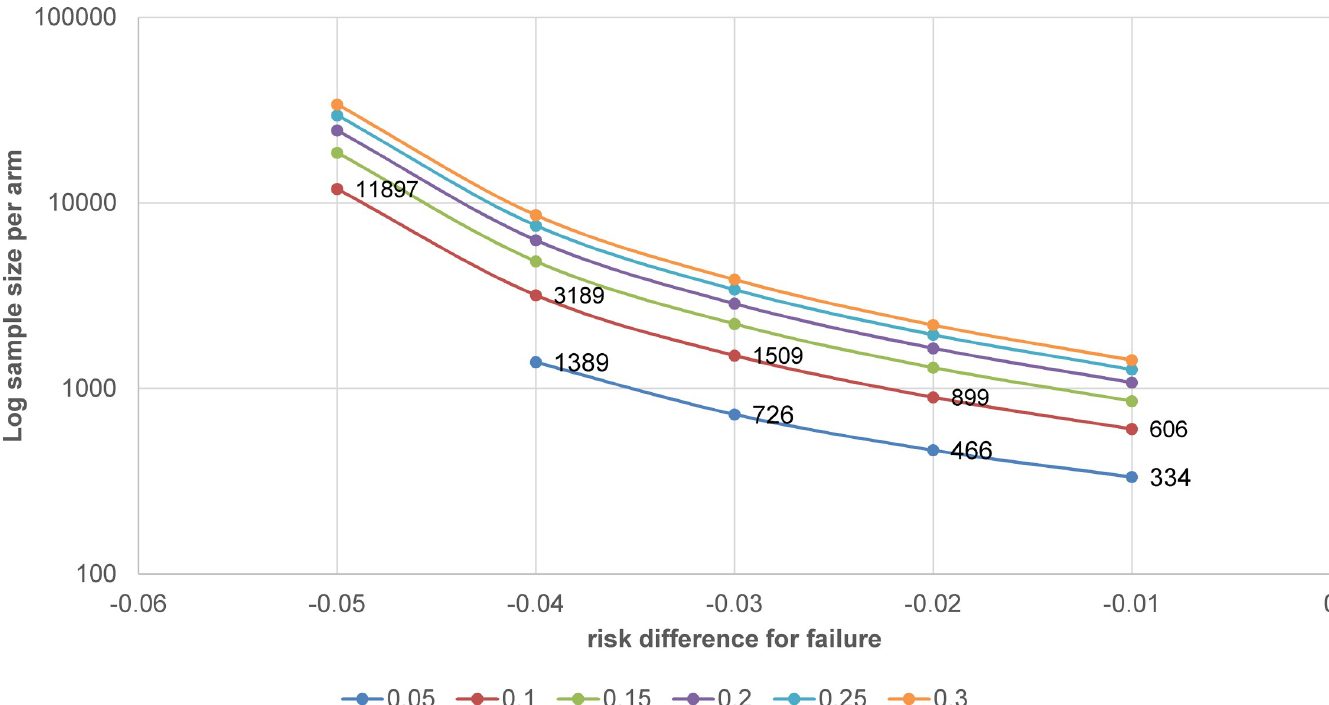
Fig 4. Example of sample size calculation with 1:1 allocation for noninferiority trial with noninferiority margin = 6%, failure rates in the control arm ranging from 5% to 30% (solid lines), and risk difference for failure between control and test treatment ranging from 1% to 5% (x-axis). The sample size was calculated with a one-sided chi-squared test for comparison of two groups by specifying the delta, the reference proportion, and the expected difference. The test statistic is assumed to have a null distribution of N(0,1). A description of the underlying calculations can be found in Julious and Owen [42].